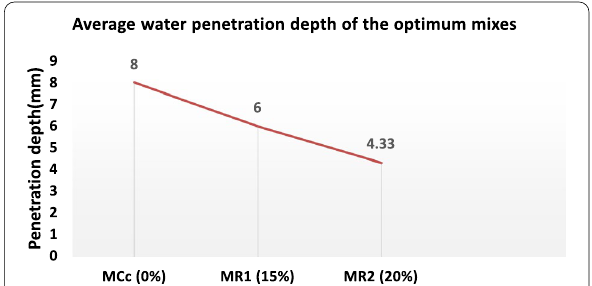
Fig. 9 Average water penetration depth of